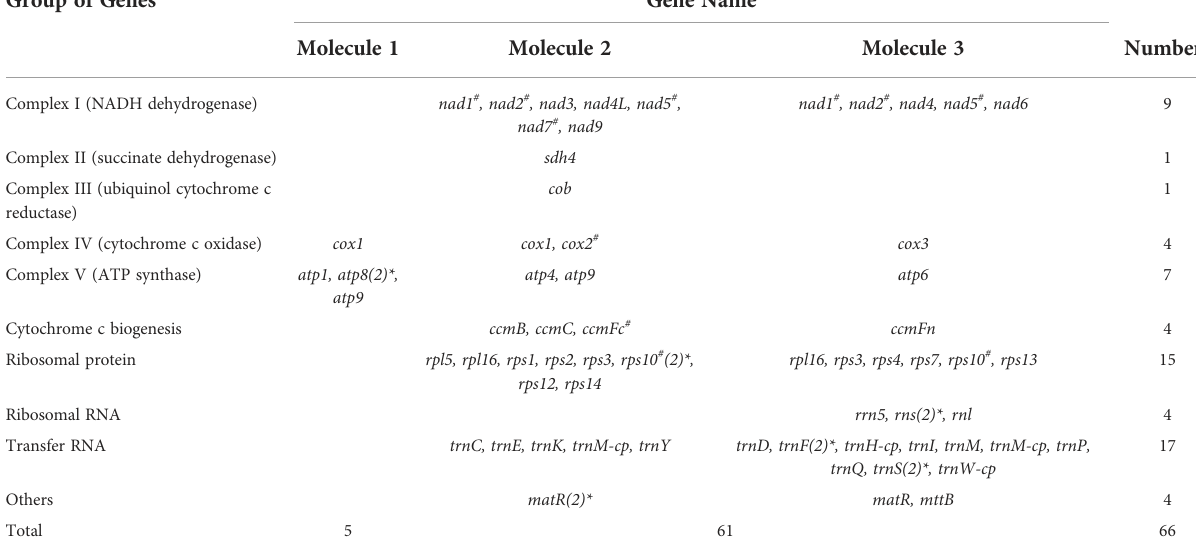
TABLE 2 Gene annotation of the H. citrina mitogenome.